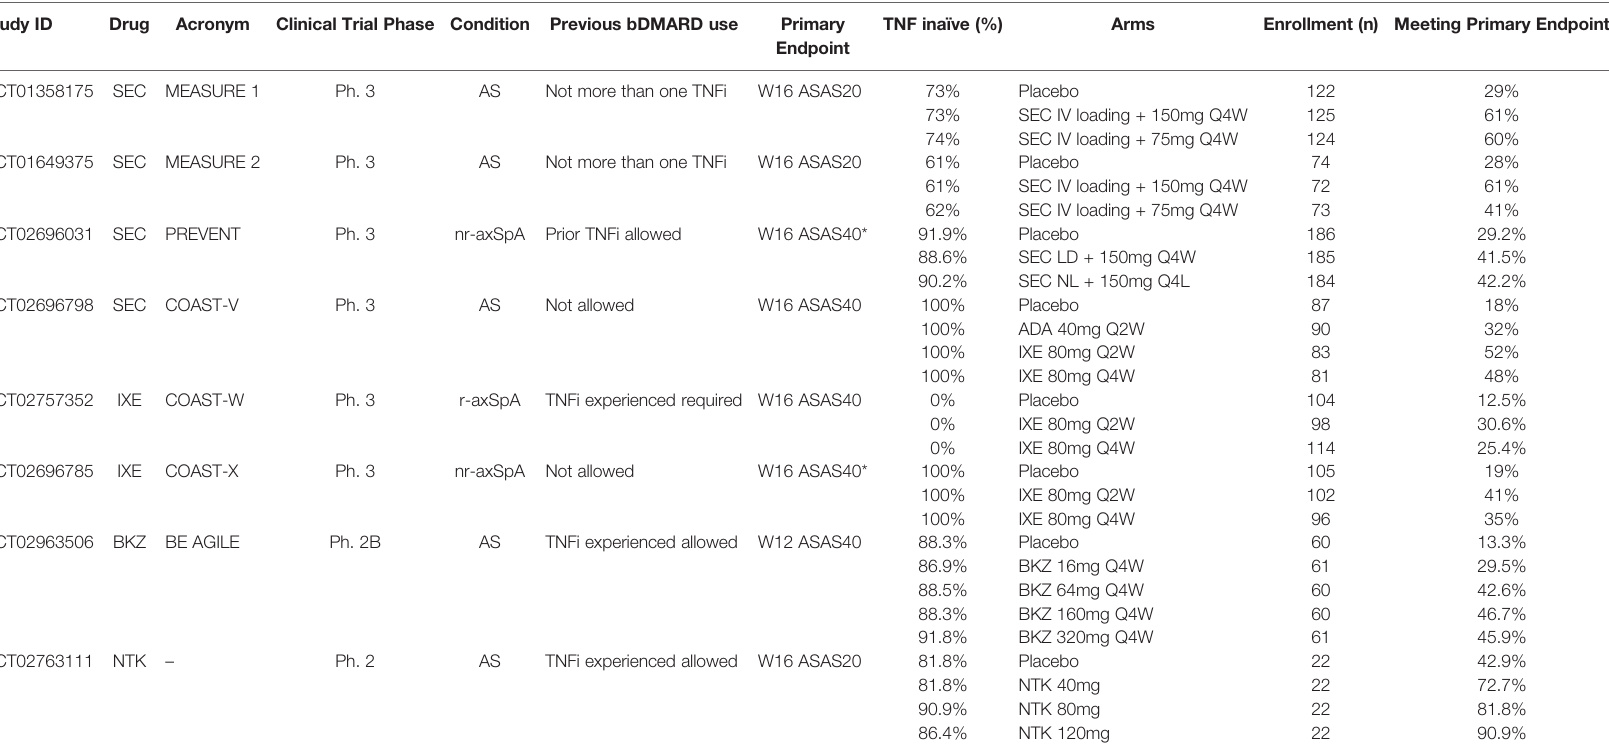
TABLE 1 | Pivotal randomized clinical trials of IL-17 inhibitors in axial